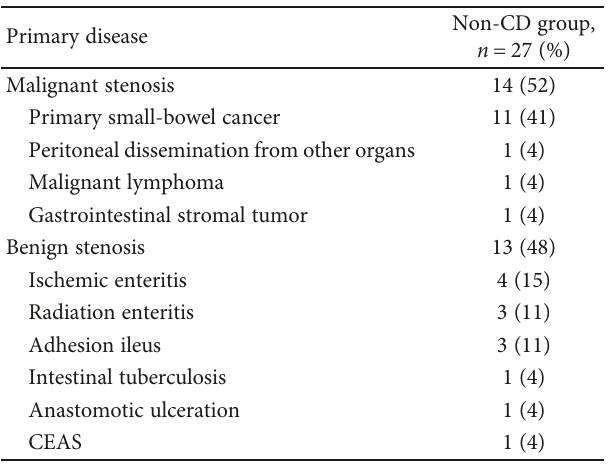
Table 3: Primary diseases of surgery cases in the non-Crohn ’ s disease group.